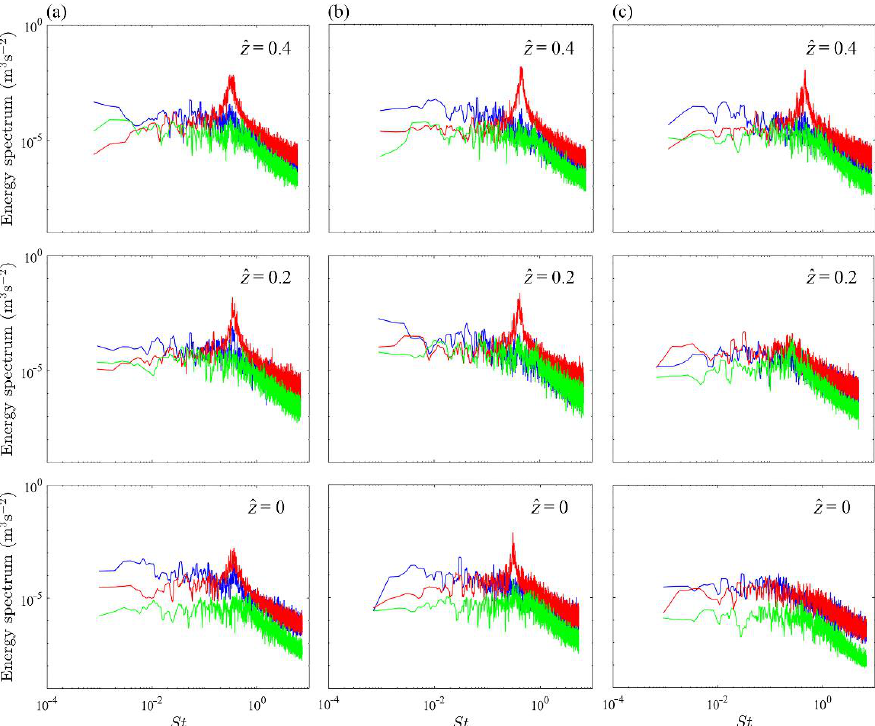
Figure 13. Energy spectra for ( a ) Run 1, ( b ) Run 2 and ( c ) Run 3 of streamwise (blue lines), spanwise (red lines), and vertical (green lines) velocity fluctuations at three different levels 𝑧̂ of the vertical W.